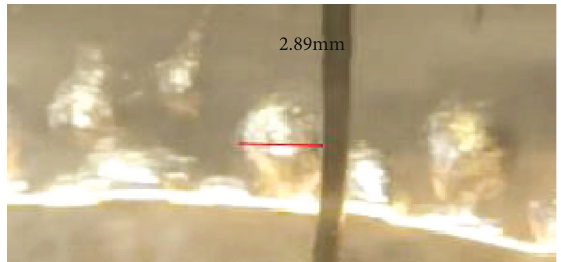
Figure 13: Bubble departure diameter for Al measured in Octave GNU.